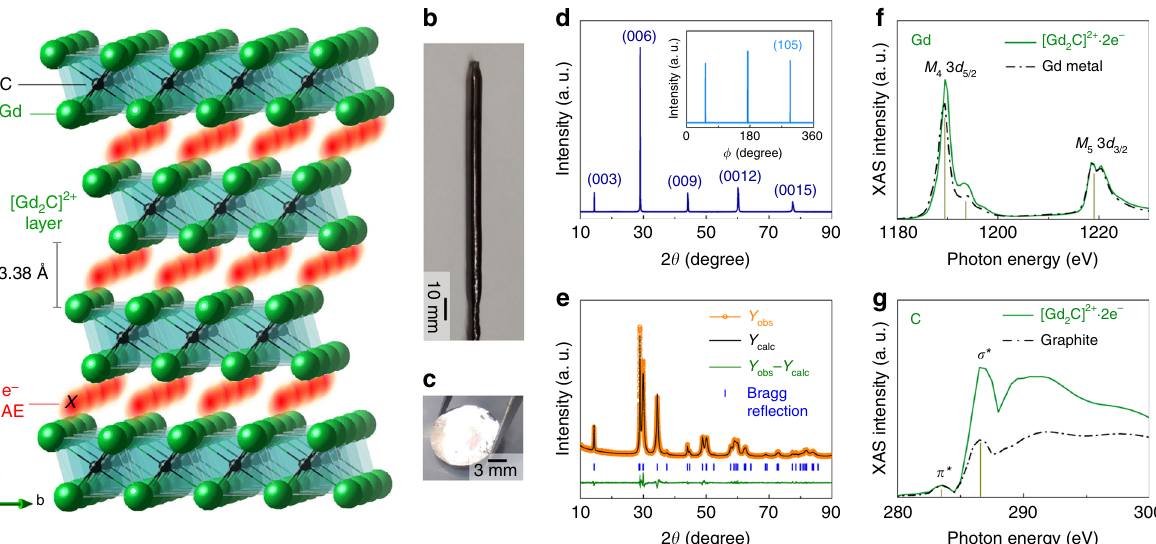
Fig. 1 2D [Gd 2 C] 2 + ·2e − electride with strongly localized IAEs. a Schematic illustration of the crystal structure of [Gd 2 C] 2 + ·2e − electride with IAEs in the interlayer space between [Gd 2 C] 2 + layers. b , c Photographs of single-crystal [Gd 2 C] 2 + ·2e − electride ( b ) and its cleaved surface ( c ). d 2 θ scan of the cleaved surface. The inset is the ϕ scan for the cleaved surface, indicating the well-constructed rhombohedral unit cell with threefold symmetry. e Rietveld re fi nement of XRD patterns for pulverized powders of a single-crystal. The detail results are given in the Supplementary Table. 1. f , g XAS spectra of Gd ( f ) and C ( g ) for single-crystal [Gd 2 C] 2 + ·2e − electride. Dashed curves are the spectra of Gd metal and electride, in which the metallic conduction along the out-of-plane is suppressed by a factor of ~60 compared with that along the in- plane direction over the entire temperature range of 2 – 400 K.